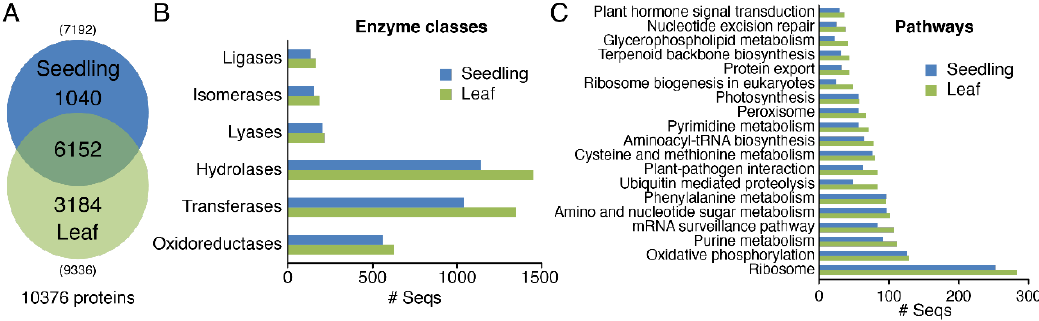
Figure 2. Profiles of proteins in seedlings and leaves of moso bamboo. ( A ) Comparison of protein numbers in seedlings and leaves of moso bamboo; ( B ) The classification of enzymes in seedlings and leaves of moso bamboo; ( C ) Pathway analysis, according to the Kyoto Encyclopedia of Genes and Genomes (KEGG) database.